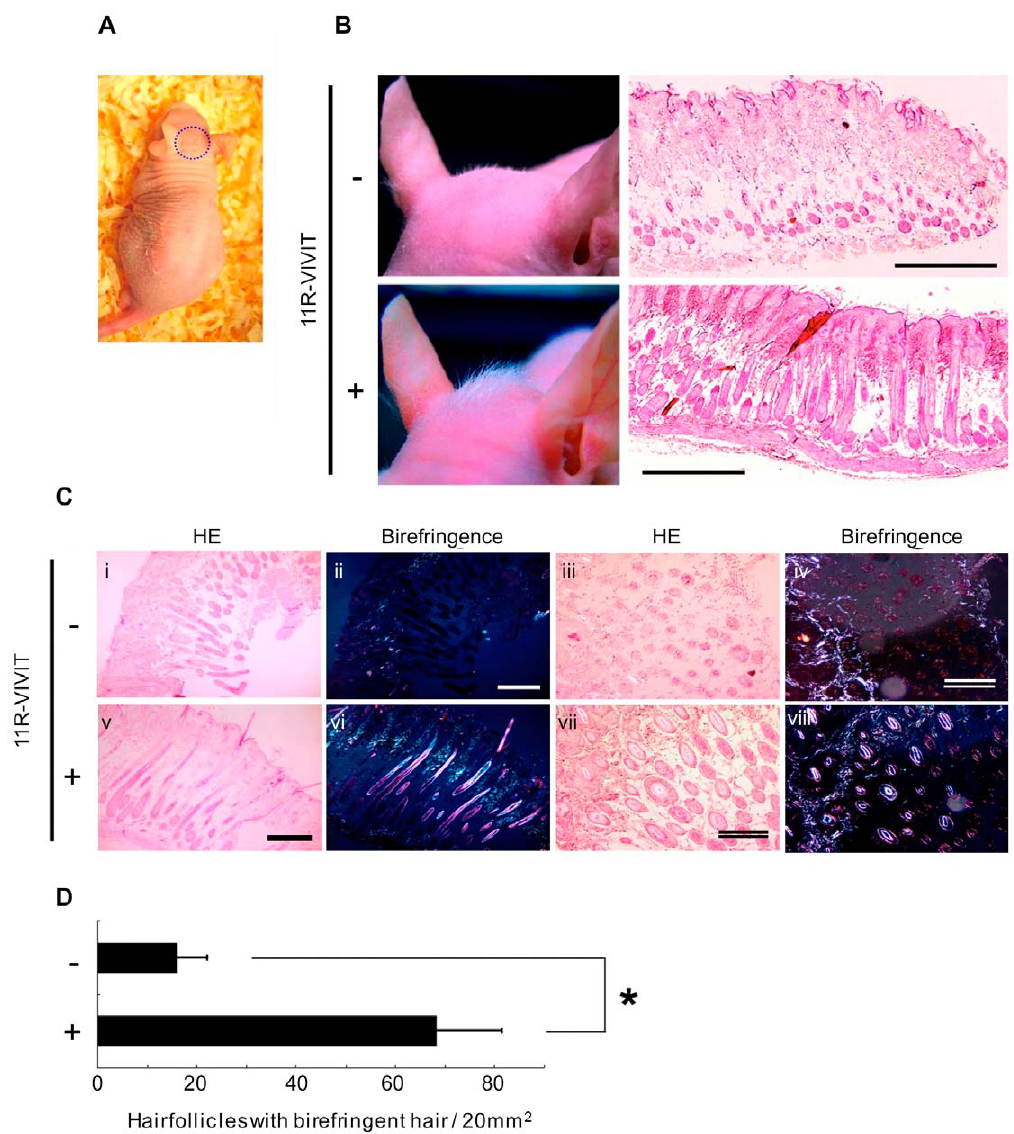
Figure 4. Effects of 11R-VIVIT on hair growth induction in nude mice. (A) The vertex region (blue circle) was chosen as the treatment spot with 11R-VIVIT. (B) Macroscopic and microscopic assessment of hair growth induction. Upper panels, control mouse treated with ointment only. Lower panels, 11R-VIVIT-treated mouse. Right panels, longitudinal sections stained with H. E. Scale bar, 1 mm. (C) Histological features of the skin of control and 11R-VIVIT-treated mice. i–iv, control mice; v–viii, 11R-VIVIT-treated mice. Longitudinal (i, ii, v and vi) and transverse (iii, iv, vii and viii) sections stained with H.E. (i, iii, v and vii), and the same sections assessed for birefringent hair shafts using a polarizing microscope (ii, iv, vi and viii). Scale bars in ii and v, 500 m m; in iv and vii, 200 m m. (D) Hair growth in control ( 2 ) and 11R-VIVIT-treated ( + ) mice was quantified using a polarizing microscope by counting the number of hair follicles containing birefringent hair shafts. n=10 each. *P , 0.0005.